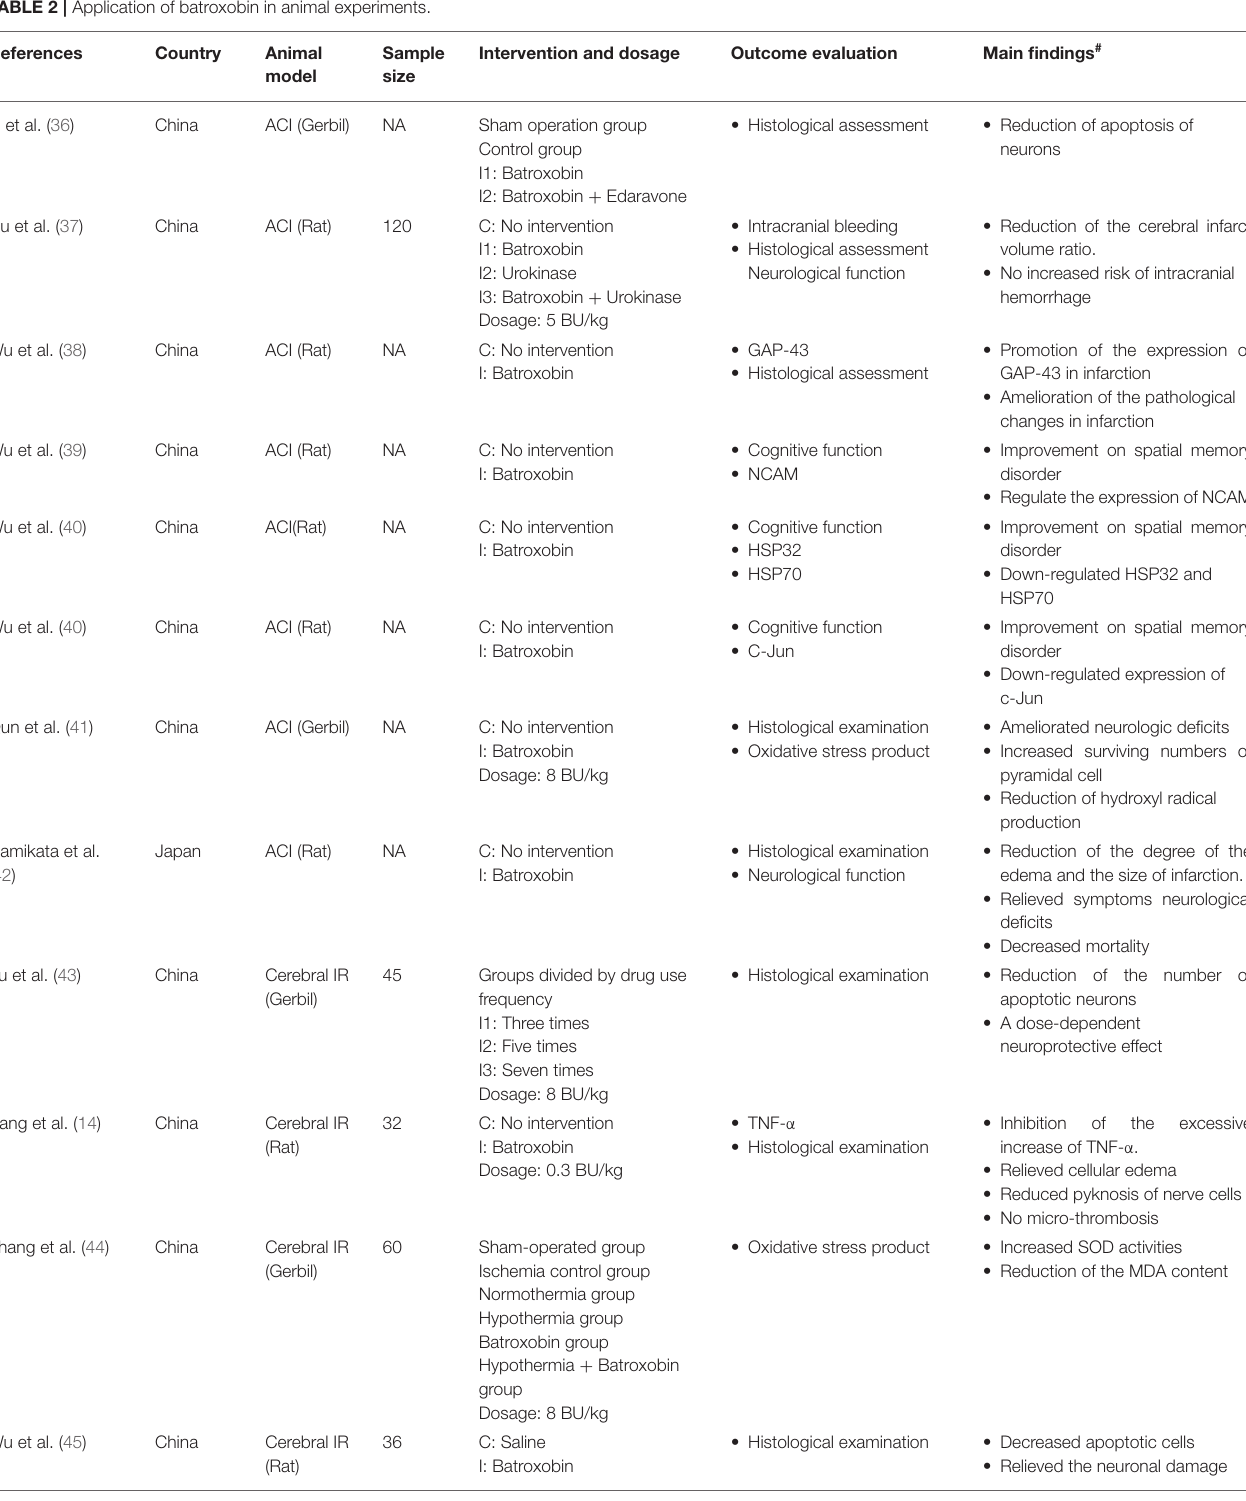
TABLE 2 | Application of batroxobin in animal